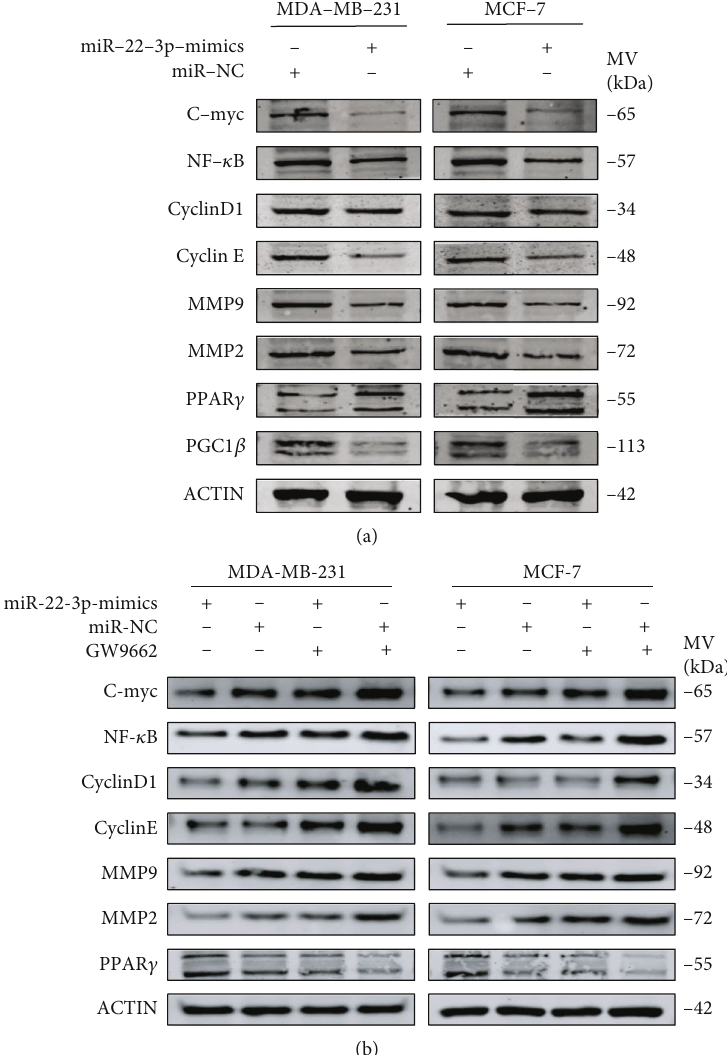
Figure 6: Inhibition of PPAR γ attenuates suppression of miR-22-3p on BC cells. (a) Upregulated miR-22-3p increased the expression of PPAR γ and decreased the expression of PGC1 β , C-myc, NF- κ B, CyclinD1, cyclin E, MMP2, and MMP9. (b) Downregulation of C-myc, NF- κ B, CyclinD1, cyclin E, MMP2, and MMP9 induced by miR-22-3p was inverted by PPAR γ inhibition